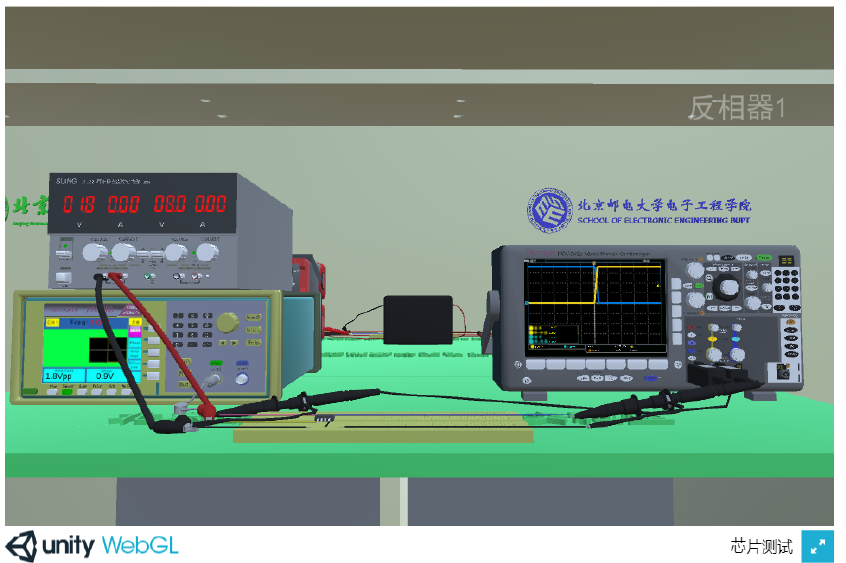
Figure 21. Inverter input/output waveform. website title of